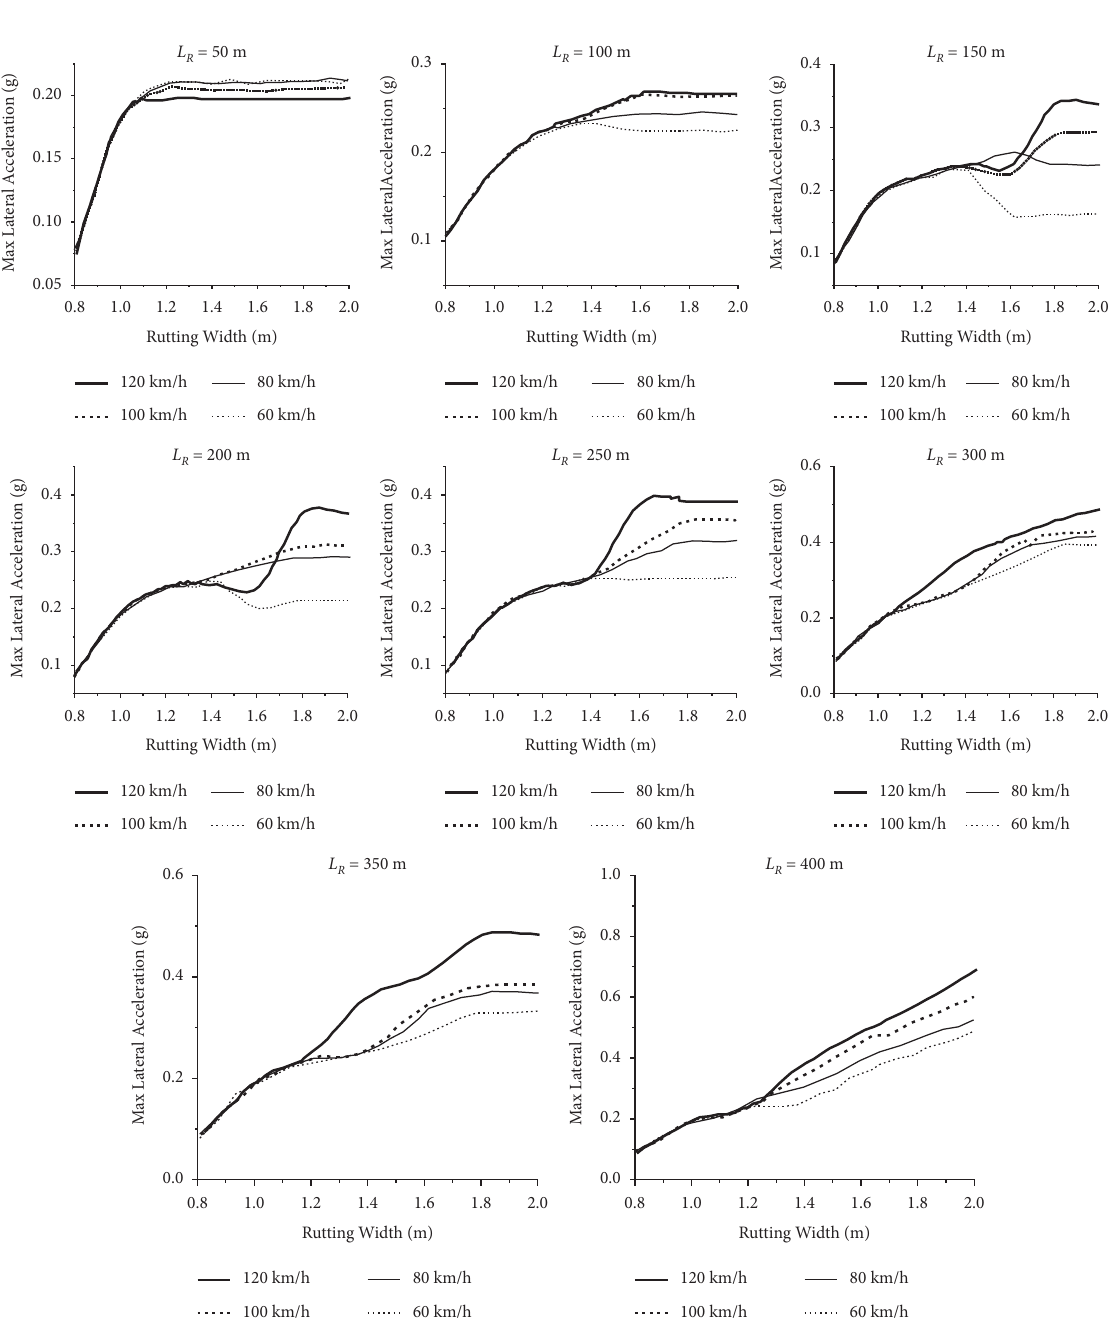
g � 0 . 4 m R refers to rutting length;